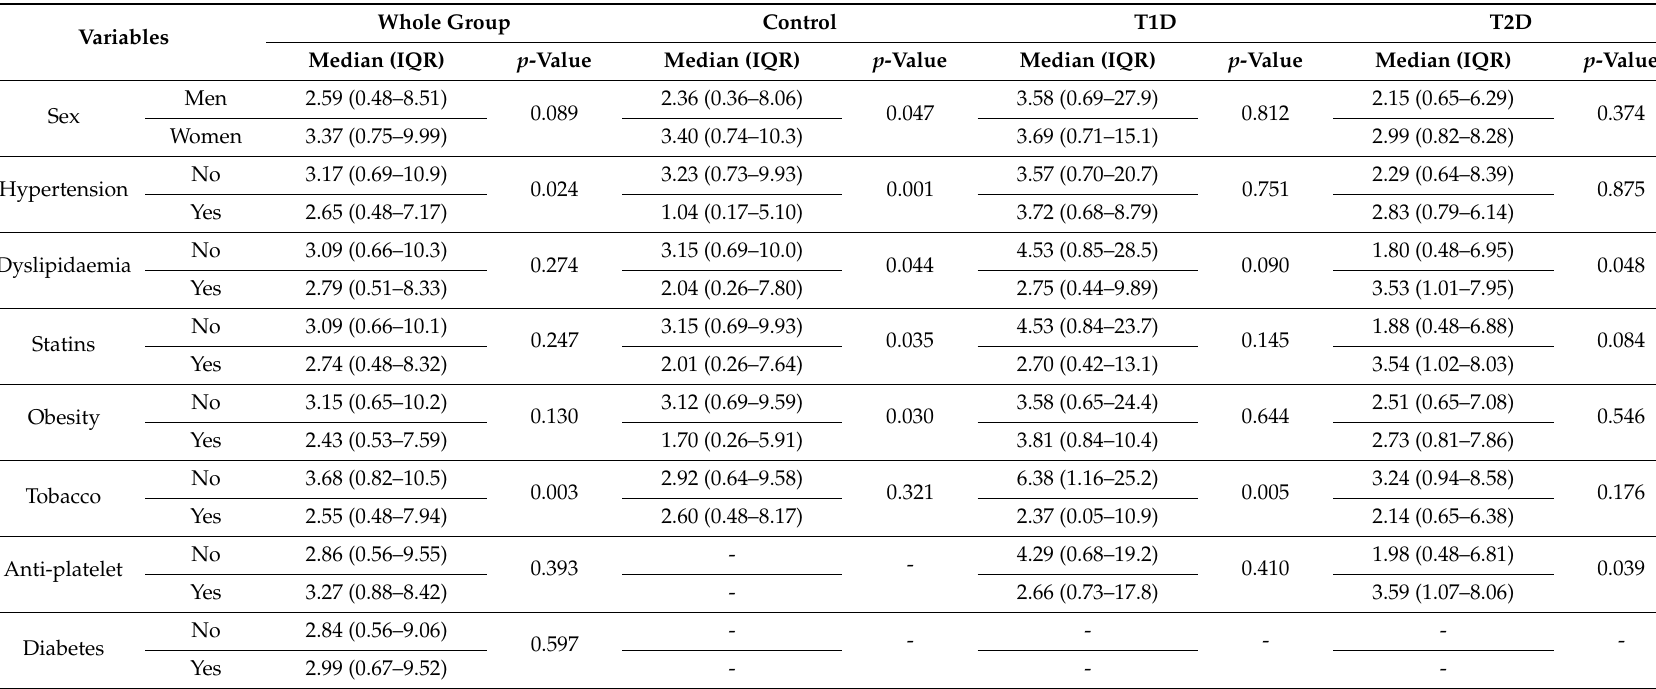
Table 2. Association of circulating sCD36 concentration and qualitative parameters in the whole study group, type 1 diabetes, type 2 diabetes, and non-diabetic